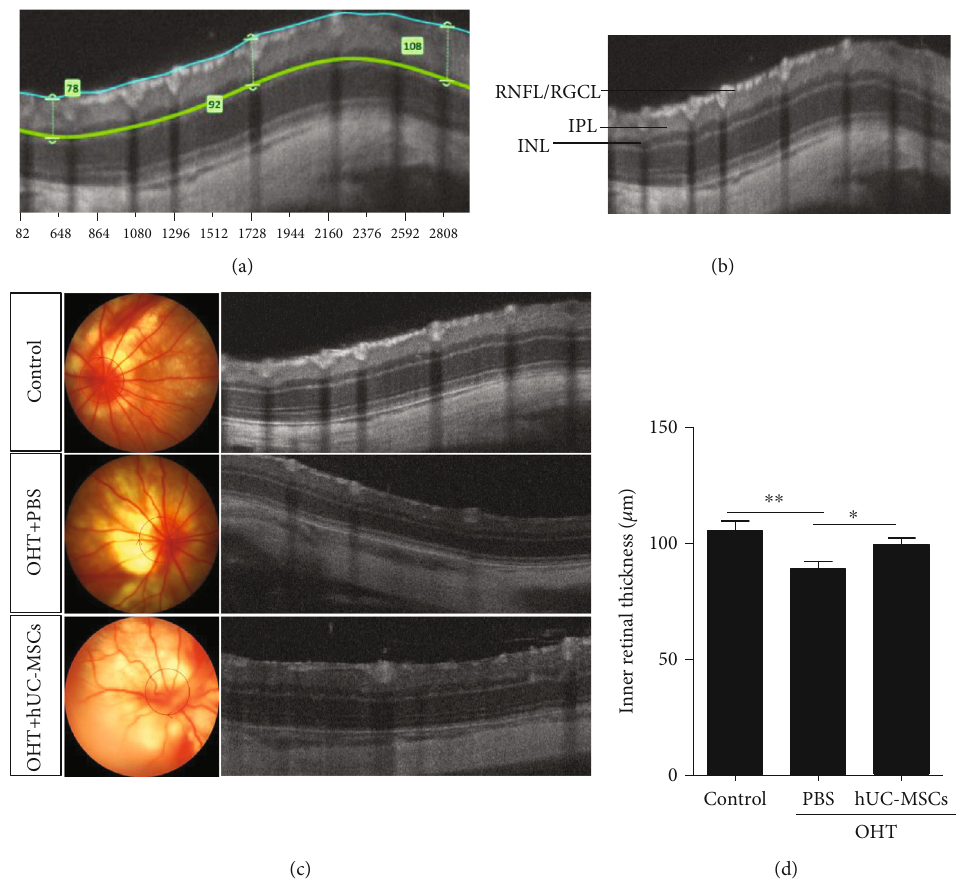
Figure 2: hUC-MSC transplantation increases the inner retinal thickness in OHT-induced rats. (a) Method of measurement of the inner retina thickness via OCT images. (b) RNFL/RGCL (retinal nerve fi ber layer/retinal ganglion cell layer); IPL (inner plexiform layer); INL (inner nuclear layer). (c) Two weeks after hUC-MSC injection. Representative fundus photography and OCT images of normal eyes, OHT+PBS eyes, and OHT+hUC-MSC eyes. (d) Results of inner retinal thickness quanti fi cation ( n = 4/group ; ∗ P < 0 : 05 and ∗∗ P < 0 : 01 compared with one-way ANOVA with Turkey ’ s post hoc